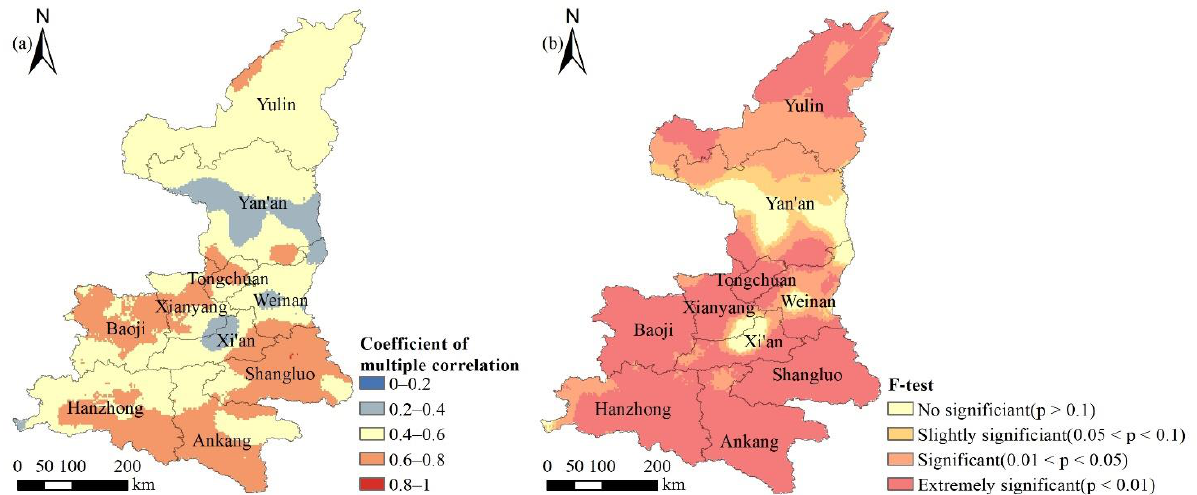
Figure 13. Spatial distribution of the multiple correlation coefficients ( a ) and its F-test results ( b ) between NDVI and temperature, precipitation in Shaanxi Province.